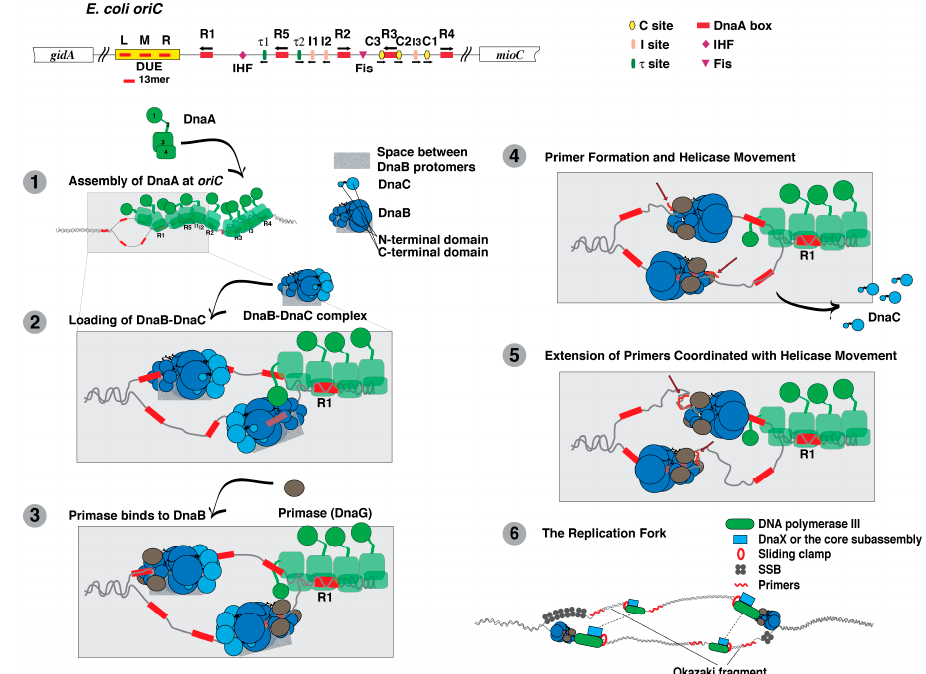
Figure 1. Replication initiation at the E. coli chromosomal origin involves the recruitment of DnaA, DnaB and DnaC to form the prepriming complex, followed by activation of DnaB, primer formation by primase, and DNA replication by DNA polymerase III holoenzyme. Shown at the top, the replication origin ( oriC ) of E. coli contains binding sites for Fis and IHF, and the DnaA boxes named R1-R5 that are recognized by DnaA in which the ATP or ADP bound to DnaA may affect the affinities to the respective sites [17,19,90,91]. In contrast, DnaA-ATP and not DnaA-ADP specifically binds to I-, τ - and C-sites. The sites named C3 and C2 overlap R3 and may be separate sites or part of R3 [17,19,90,91]. ( 1 ) DnaA, which has four functional domains as noted in the figure of DnaA, recognizes specific DNA sites in E. coli oriC to form a DnaA oligomer. DnaA then unwinds a region containing the 13mers named L, M and R; ( 2 ) Domain I of DnaA interacts with the N-terminal domain of DnaB in the DnaB-DnaC complex to load the complex onto the top and bottom DNA strands of the unwound region, forming a macromolecular entity named the prepriming complex. The shaded rectangle represents the space between adjacent DnaB protomers through which the single-stranded DNA passes during helicase loading; ( 3 ) Primase interacts with the N-terminal domain of DnaB, which is required for primer synthesis. In the transition to the next step, the open space between adjacent DnaB protomers presumably closes; ( 4 ) Primer synthesis (shown as red wavy lines) by primase on the top and bottom strands and the translocation of DnaB leads to the dissociation of DnaC from DnaB; ( 5 ) After primer synthesis, primase will dissociate from DnaB as the primer is bound by DNA polymerase III holoenzyme. DnaB will move to the junction of each replication fork; ( 6 ) DNA polymerase III holoenzyme extends the primers for the synthesis of each leading strand. DnaB at the junction of each replication fork unwinds the parental duplex DNA. The transient interaction of DnaB with primase as the helicase moves leads to the synthesis of subsequent primers that are extended by DNA polymerase III holoenzyme in the synthesis of Okazaki fragments. The dashed lines represent the contacts between two units of DNA polymerase III holoenzyme, forming a dimer in the coordinated synthesis of the leading and lagging strands.